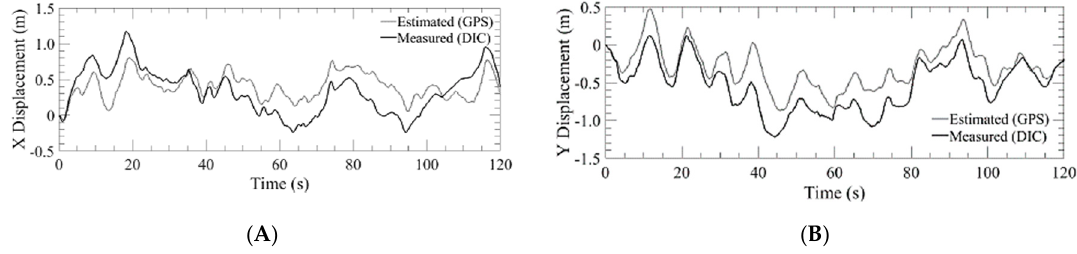
Figure 12. Lateral displacement estimated by GPS of the DJI S1000+ versus the measured value of the DIC for run 2 where: ( A ) X displacement; ( B ) Y displacement.